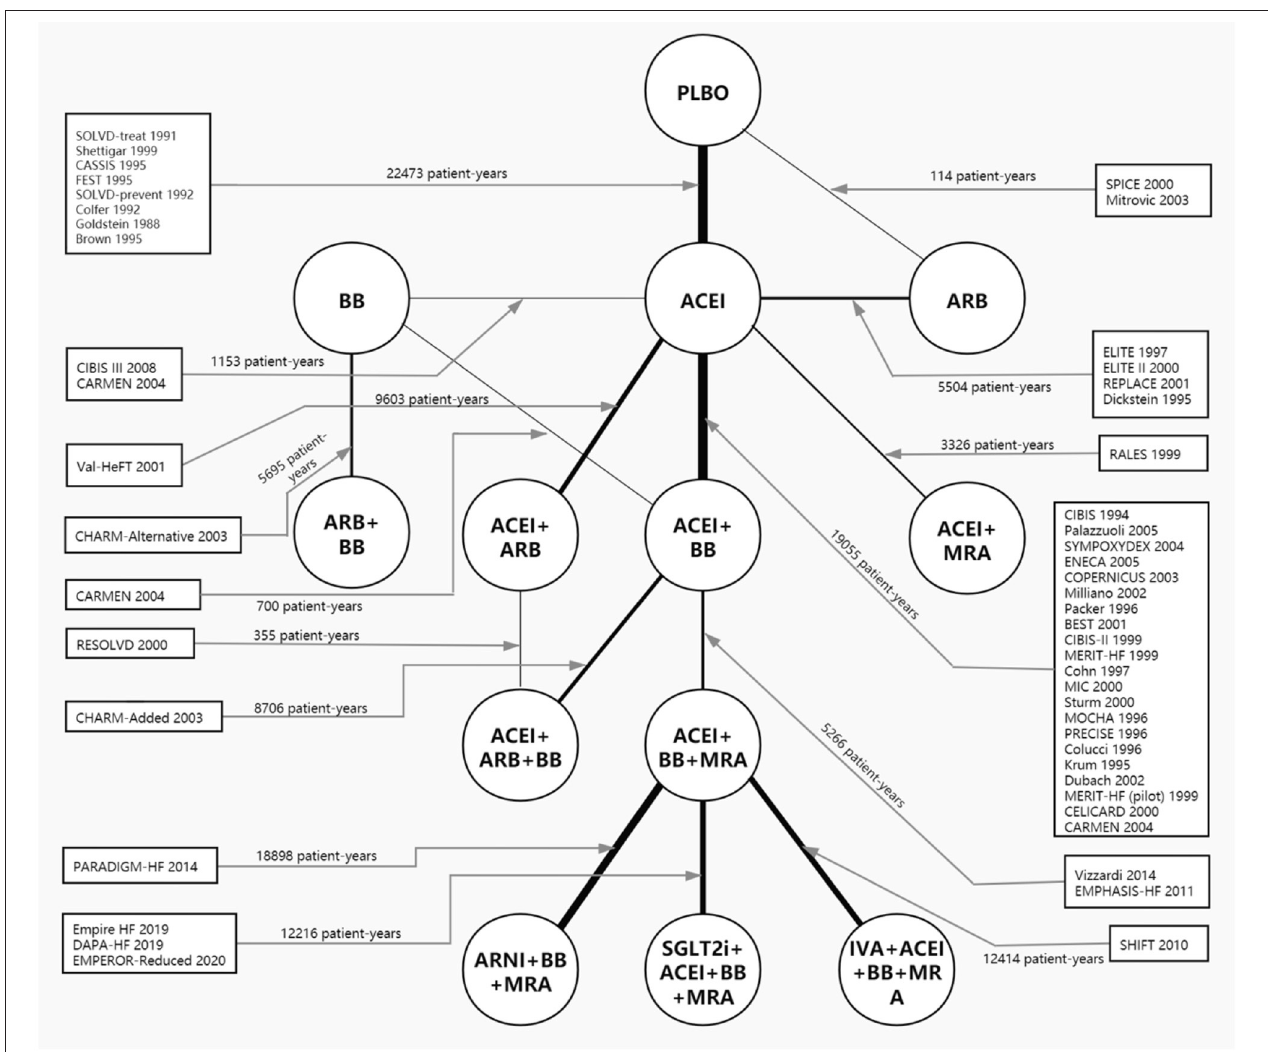
FIGURE 1 | Network plot of all included studies reporting all-cause mortality. The thickness of the connecting lines was related to the number of patient-years of evidence for each intervention comparison. Network plots for cardiovascular mortality and hospital admission for heart failure are provided in Supplementary Figure 2 . ACEI, angiotensin-converting enzyme inhibitor; ARB, angiotensin receptor blocker; ARNI, angiotensin receptor-neprilysin inhibitor; BB, beta-blocker; IVA, ivabradine; MRA, mineralocorticoid receptor antagonist; PLBO, placebo; SGLT2i, sodium-glucose cotransporter 2